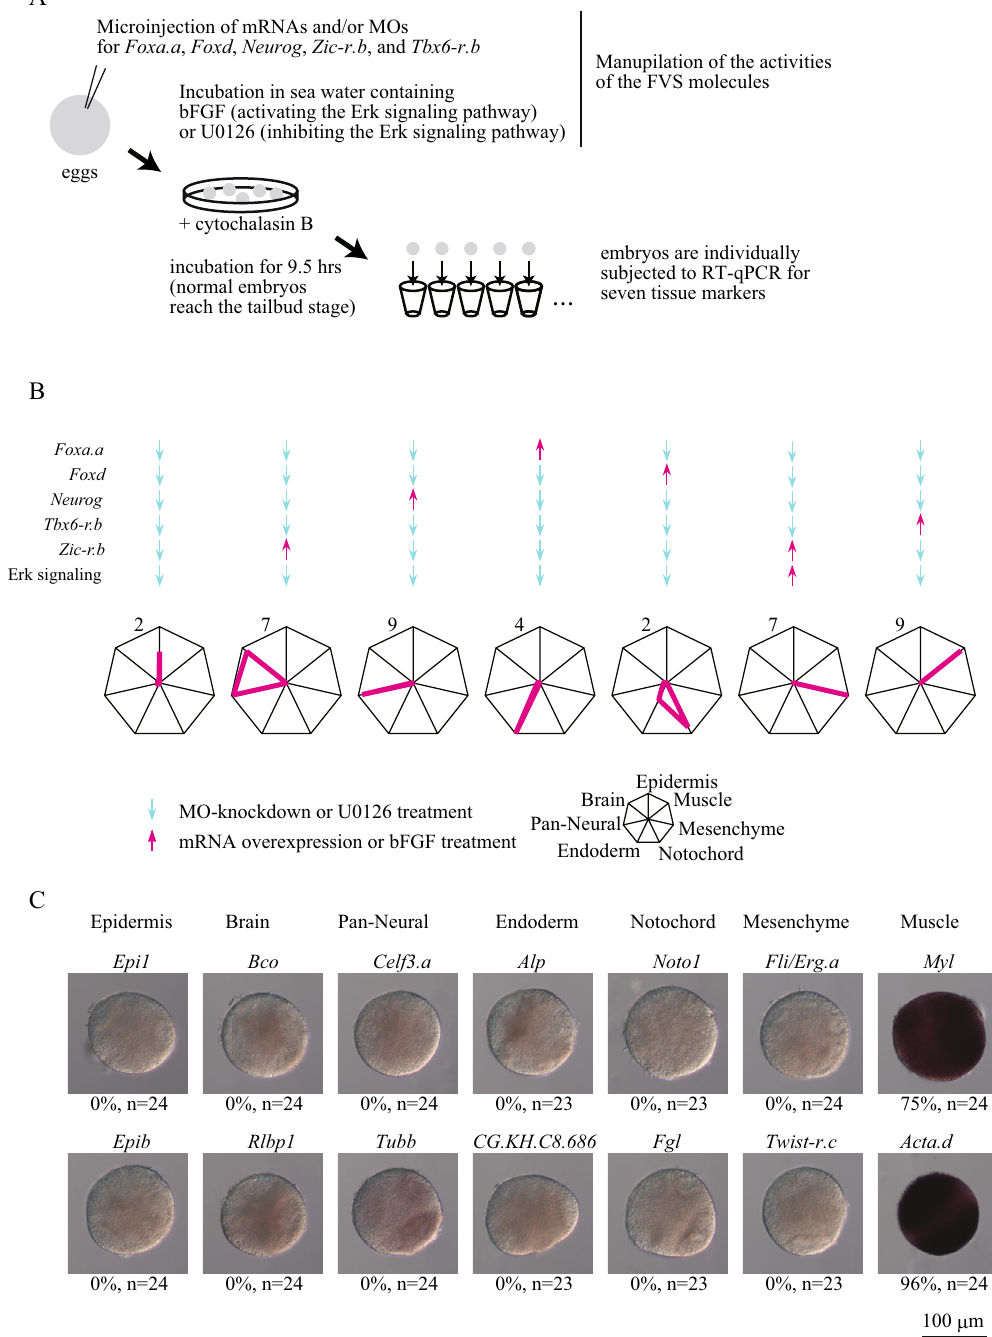
Figure 2. Seven different cell types are reproduced by manipulating activities of FVS factors in single-cell syncytium embryos. ( A ) The experimental design. ( B ) FVS factors are up- or down-regulated in seven different combinations, as shown at the top. Radar graphs show expression levels of marker genes relative to their corresponding values in normal 9.5-h (tailbud) embryos in the seven experimental conditions. Each axis shows expression of a tissue marker as shown at the bottom. Mean values for 12 embryos from two batches (six from each) are shown. Values for individual embryos are shown in Fig. 3. Note that brain cells express the brain and pan-neural markers. ( C ) In situ hybridization of single-cell syncytium embryos in which Tbx6-r.b was overexpressed and the remaining FVS factors were down-regulated. Only muscle marker genes were expressed. Percentages that expressed the indicated markers and numbers of embryos we examined are shown beneath the photographs. Marker genes that were also used in the RT-qPCR assay shown in ( B ) are shown in the upper